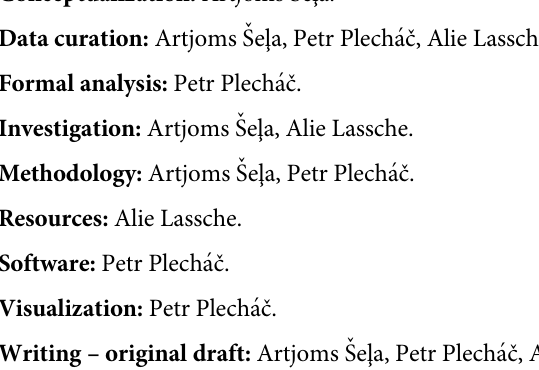
S4 Table. Corpora filtering. Step 1 gives the number of poems after exclusion of other than accentual-syllabic poems (these include for instance free verse, accentual verse, syllabic verse), poems where less than 80% of lines are written in a single meter, poems outside the selected time span and poems outside the required length span (4 to 100 lines). The figure in parenthe- ses gives how many poems remain after this step as compared to the entire corpus. Step 2 gives the number of poems when keeping only the most common iambic and trochaic meters. The figure in parentheses gives how many poems remain after this step as compared to the previ- ous one. S5 Table. H2 model coefficients, truncated normal. Fit of a Bayesian regression model with Hamiltonian Monte Carlo sampling (4 chains, 2000 iterations, 1000 warmup); brms formula: ARI | trunc ( up = 1) * 1 + period � language . Categories are index-coded, reference level for pre- dictors is Czech for languages and early for period. Bulk_ESS and Tail_ESS are measures of effective sample size. at 1 signifies chain convergence. effective sample size. ^ R at 1 signifies chain